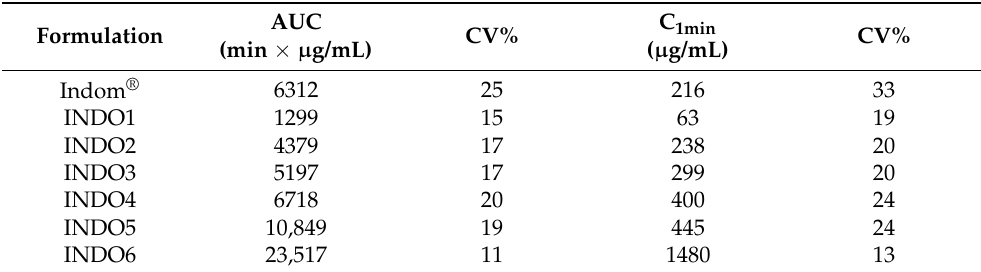
Table 5. Pharmacokinetic analysis of the indomethacin concentrations in tear fluid. AUC is the area under the curve until infinity.